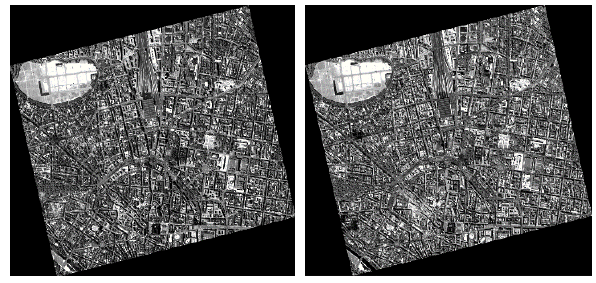
Figure 7. An example of WorldView-2 epipolar image pair